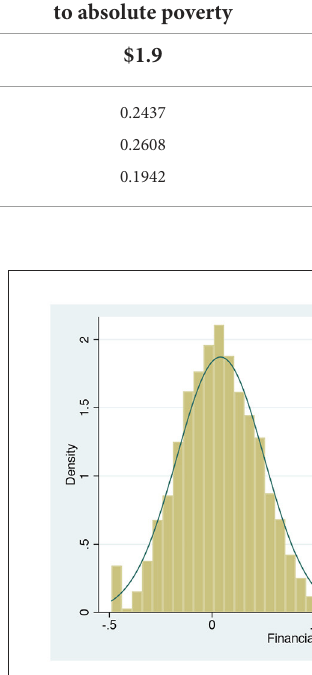
FIGURE2 The distribution of the financial literacy